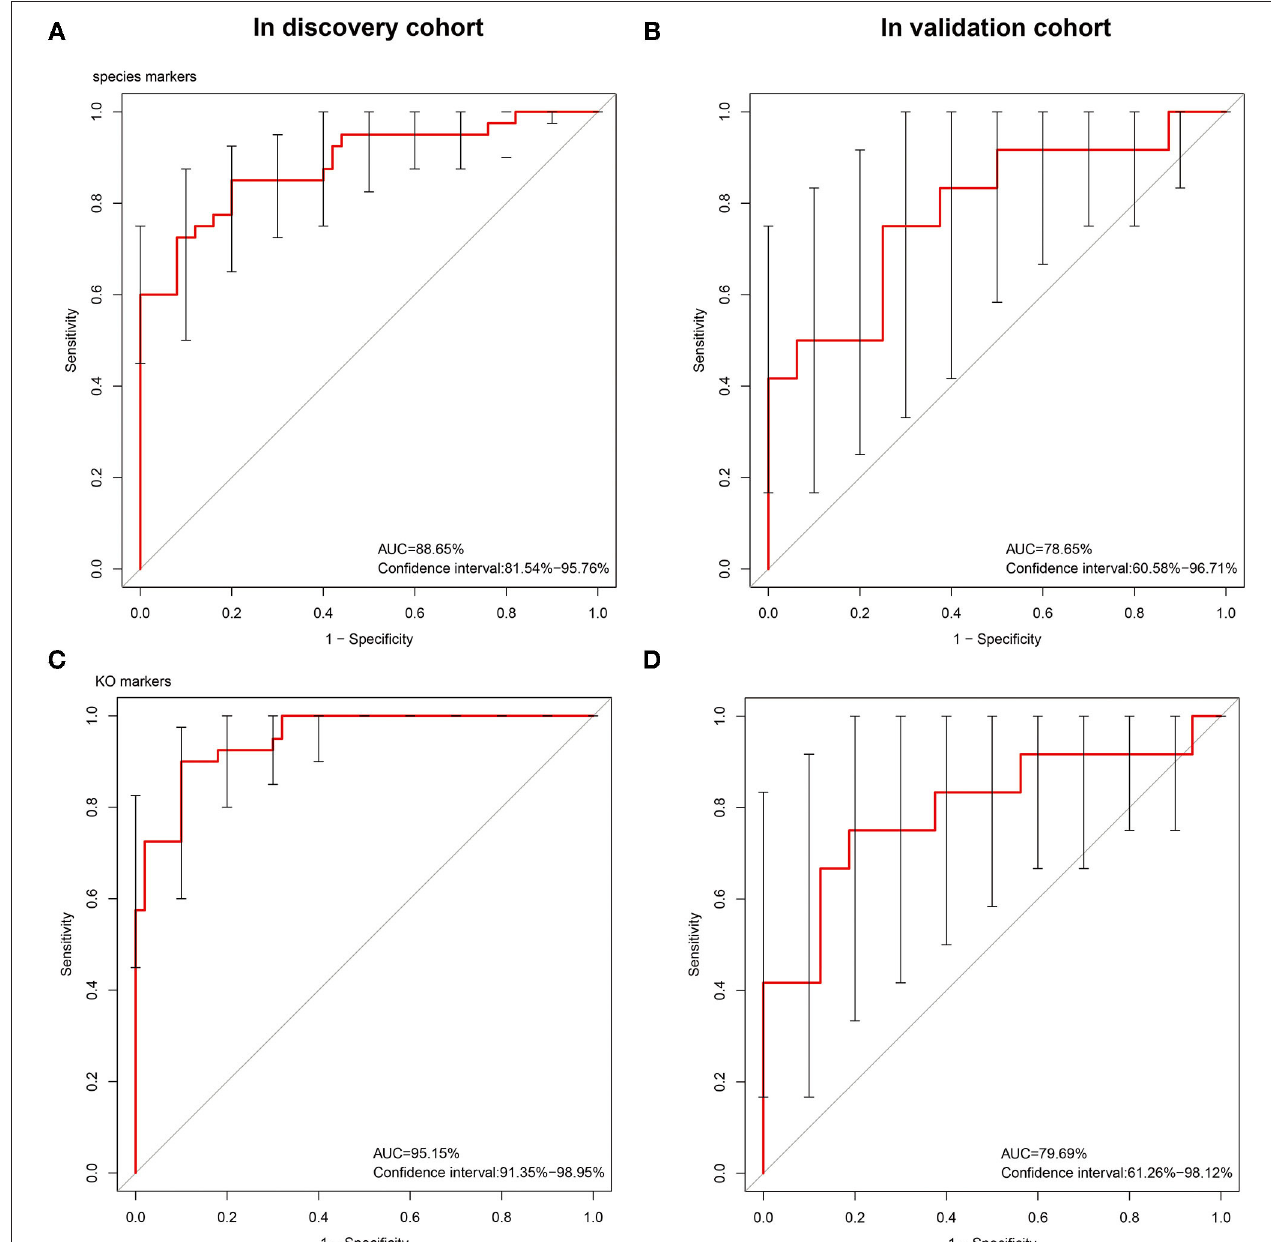
FIGURE 3 | The receiver operating characteristic (ROC) curves of the sequenced reference species markers and the KEEG Ontology (KO) markers. The classification model constructed using 15 species as biomarkers had an AUC of 88.65% in the discovery set (A) and 78.65% (B) in the validation set. We constructed a classification model using the 10 differentially expressed KO markers with the most advantageous ROC curve values among the 859 differentially expressed KO biomarkers. This model had an AUC of 95.15% (C) in the discovery set and 79.69% (D) in the verification